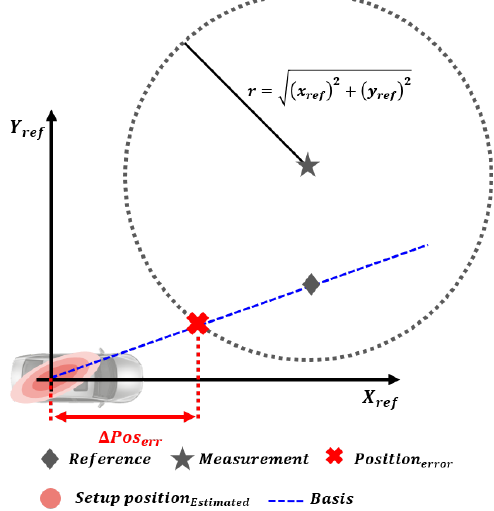
Figure 7. The intersection point between basis and the equation of